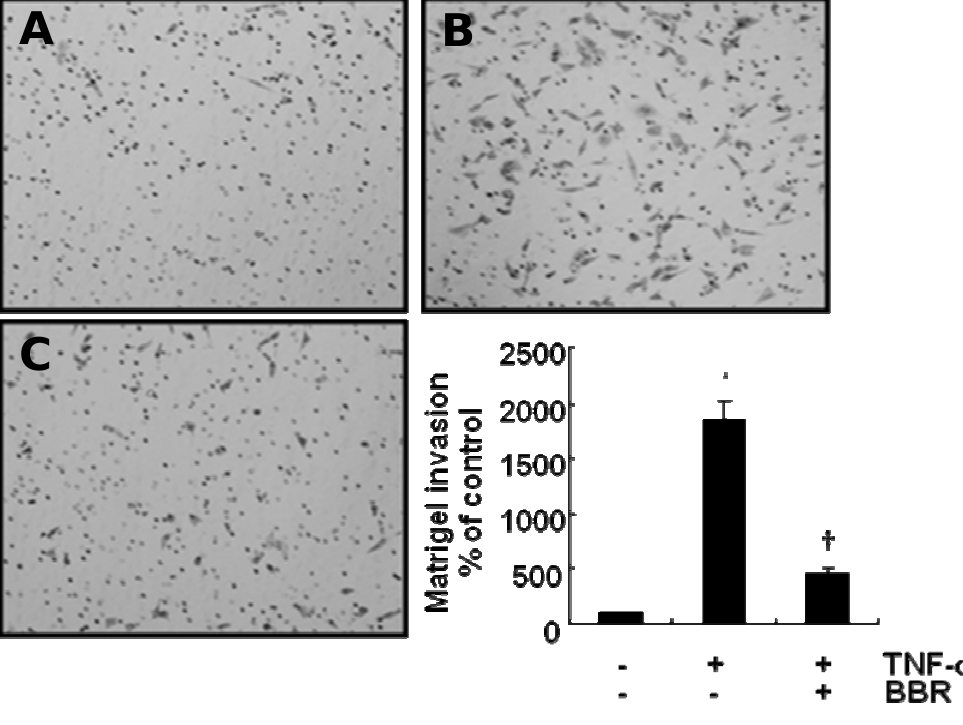
Figure 4. TNF- α -induced cell invasion was suppressed by berberine in MDA-MB-231 cells. After seeding of 1 × 10 5 cells/well, cells pretreated with 10 μ M berberine for 1 h and then treated with 20 ng/mL TNF- α for 24 h. After 24 h incubation, cells on the bottom side of filter were fixed, stained and conunted. (A) Control; (B) TNF- α alone; (C) TNF- α with berberine. These results were representative of three independent experiments. Values shown are means ± SEM. * P < 0.01 vs . control, † P < 0.01 vs . TNF- α -treated cells.